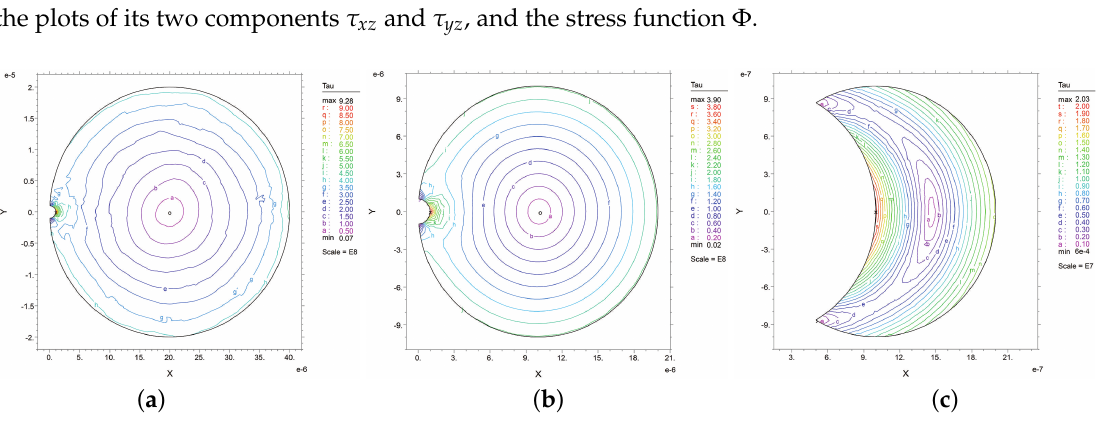
Figure 11. Shear stress (10 8 Pa) map for: h = 20 r ( a ); h = 10 r ( b ); and h = r ( c ).